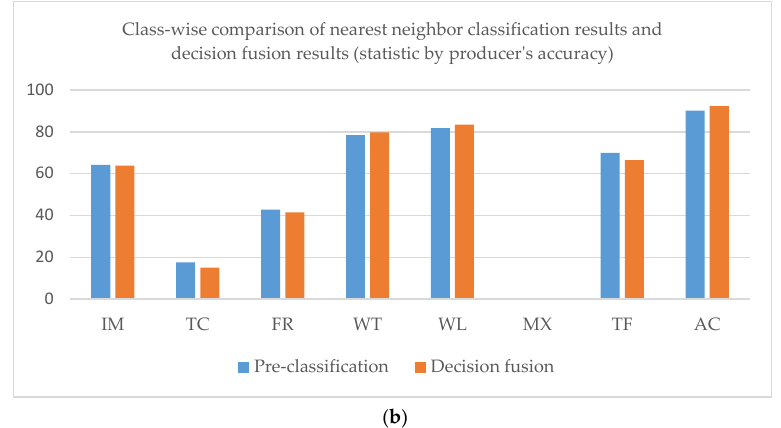
Figure 18. Class-wise comparison of fuzzy SVM classification results and decision fusion results (statistic by user’s accuracy ( a ) and producer’s accuracy ( b )) in Kent County.